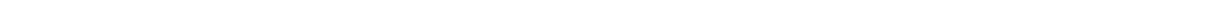
Fig. 4 CRIT selects for CD49d cells in MM model. a Bioluminescence intensity plot showing resistant nature of MM cells extracted from treated cohort (MM1 CRIT-RES ) upon rechallenging with CRIT in fresh mice. b No difference in GLUT1 mRNA expression was observed between parental MM1.S cells and resistant MM1.S CRIT-RES cells as assessed by qRT-PCR. ns not signi fi cant. c – h No difference in expression of CD29 was observed between MM1.S cells ( c ) or MM1.S CRIT-RES cells ( d ) following treatment with CRIT in vivo. MM1.S stopped responding to CRIT by downregulating expression of VLA-4 subunit CD49d (Resistance = 28.12% CD49d+) ( f ) relative to parental cells injected into mice at the beginning of the experiment (parental = 99.92%